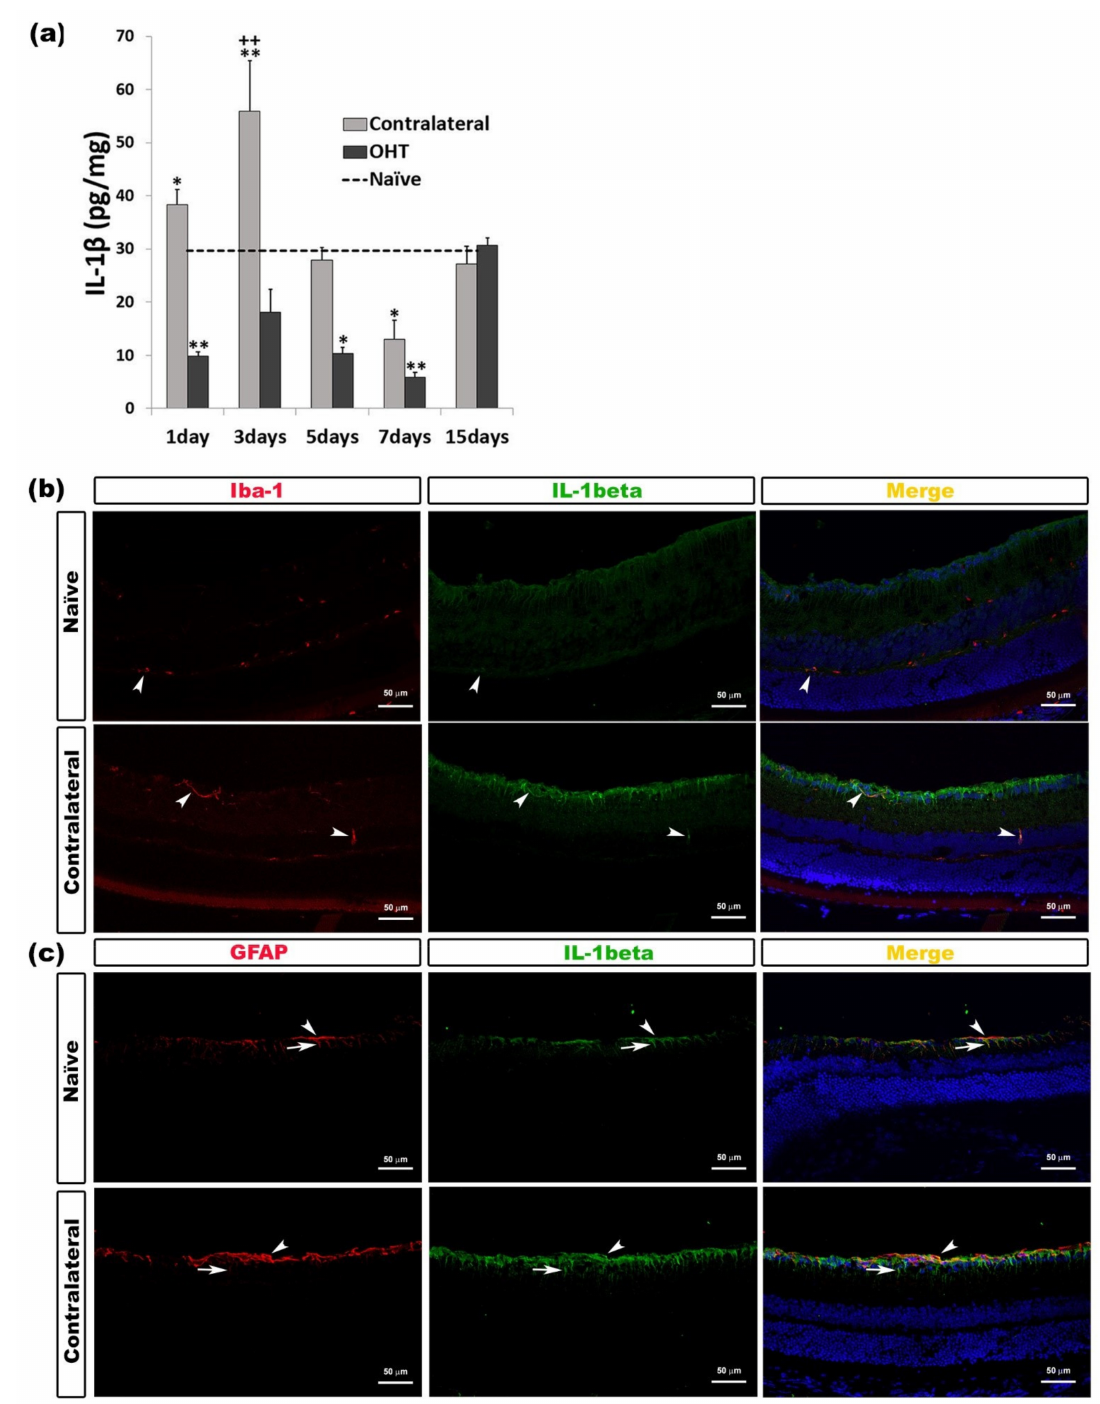
Figure 2. IL-1 β levels at different times after laser-induced ocular hypertension (OHT). ( a ) The variation over time in the IL-1 β levels in the multiplex assay. The histogram shows the mean levels ( ± SD) of IL-1 β (pg/mg) at days 1, 3, 5, 7, and 15 after laser OHT induction, in ocular hypertension eyes (OHT) and in contralateral eyes. The dashed line indicates the mean levels in naïve eyes. Statistical significance indicators: * p < 0.05, ** p < 0.01 vs. naïve; ++ p < 0.01 vs. OHT. ( b , c ) Immunohistochemical study of IL-1 β expression in naïve and contralateral eyes three days after unilateral laser-induced OHT. Retinal sections were immunolabeled with antibodies to IL-1 β (green), Iba-1 (red in ( b )), or GFAP (red in ( c )). Merge (yellow). ( b ) The arrowheads show the co-expression of Iba-1 and IL-1 β . This expression is higher in contralateral eyes than in naïve eyes. ( c ) Arrowheads (astrocytes) and arrows (Müller cells) indicate the co-expression of GFAP and IL-1 β , with the expression being more intense in contralateral than in naïve eyes. Abbreviations: OHT (ocular hypertension); IL-1 β (interleukin 1 beta); GFAP (glial fibrillary acidic